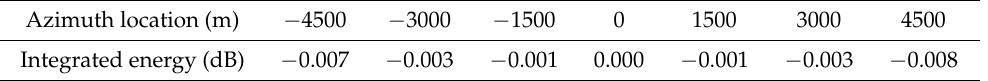
Table 5. Imaging results for targets at azimuth scene center, calibrated by the proposed method. Azimuth location (m) − 4500 − 3000 −